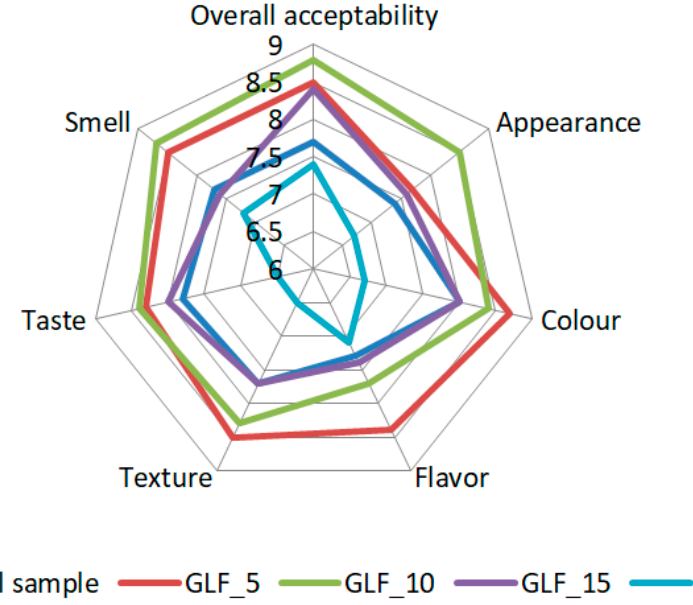
Figure 5. Sensory analysis for the bread samples .